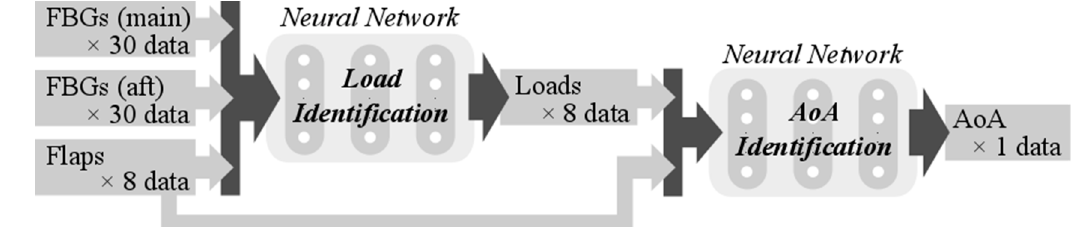
Figure 12. Design of NN ‐ based identification process for load and AoA.